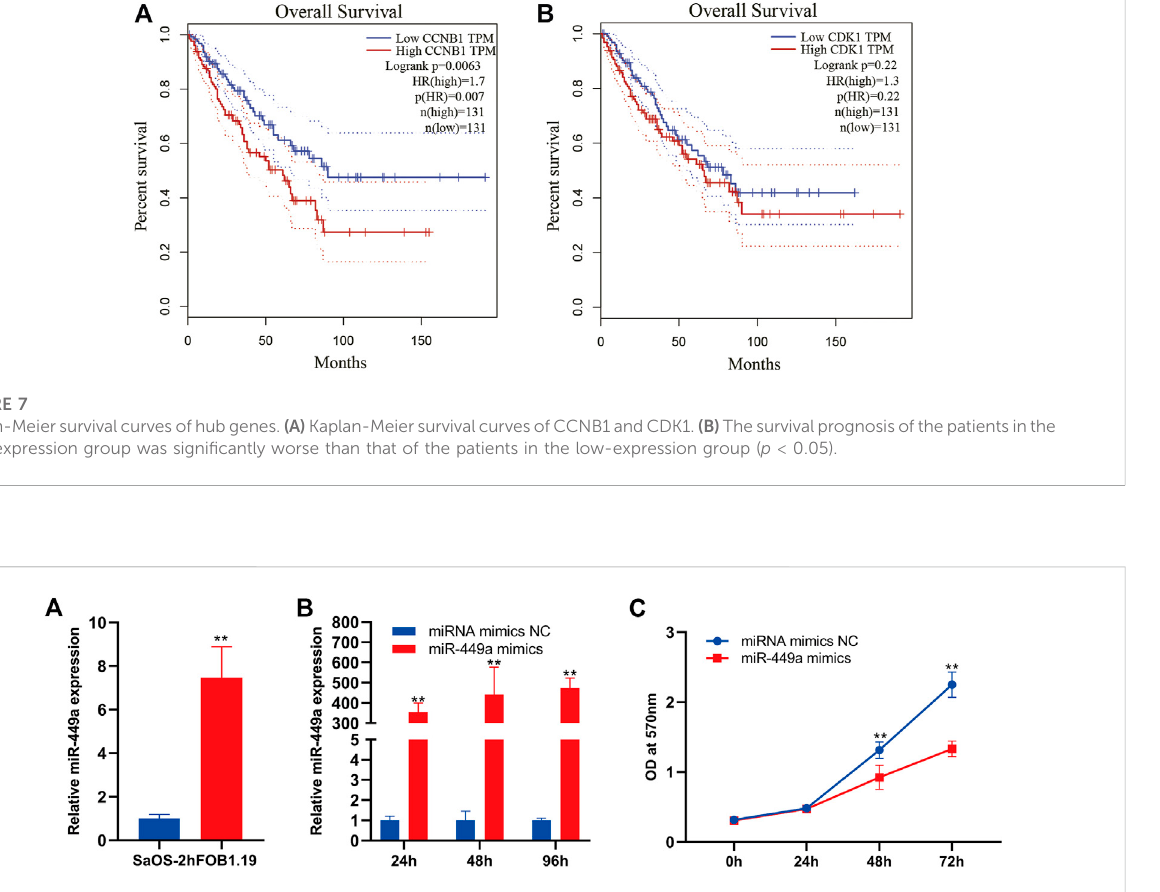
FIGURE 8 miR-449ainhibitsproliferationofSaOS-2cell. (A) RT-qPCRofthegeneexpressionlevelsofmiR-449ainhFOB1.19andSaOS-2cells. (B)